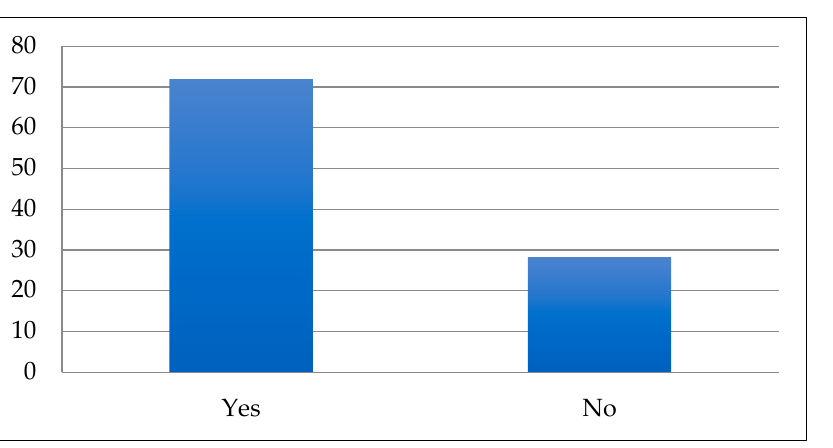
Figure 14. Contribution of domestic design to the ability to self-isolate.